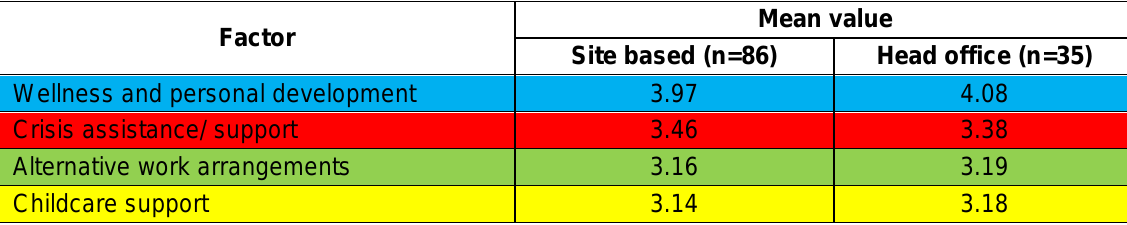
Table 6 Work-life benefit factor preferences mean scores for different work locations The relative importance of the 4 factors was identical for site (n=86) and head office